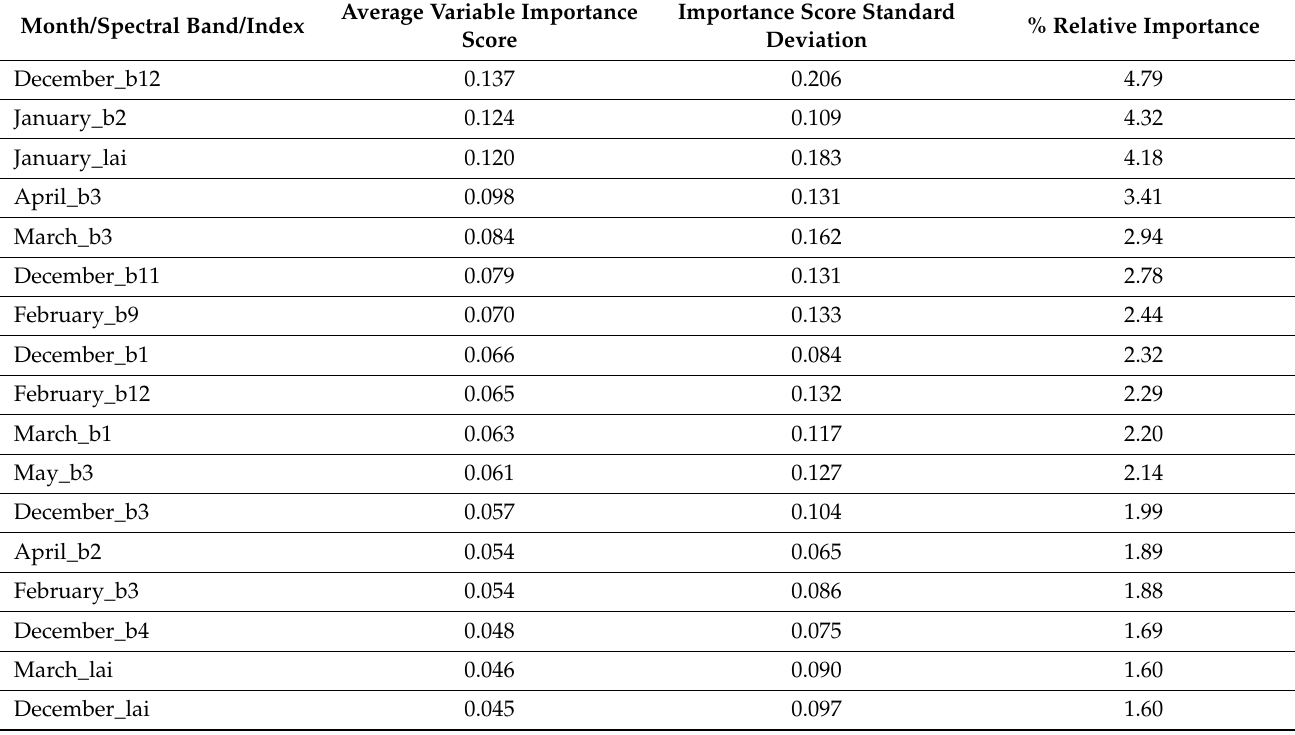
Table A1. Best variables in image ensemble classification selected from the preliminary analysis. The percentage shows the relative importance across all variables tested. The 17 variables with higher average importance combined perform approximately 45% of total importance.